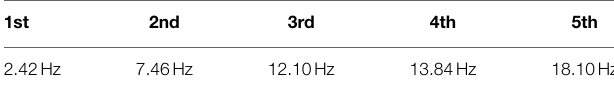
TABLE 2 | Estimated natural frequencies in short-span direction from transfer function (roof/base)